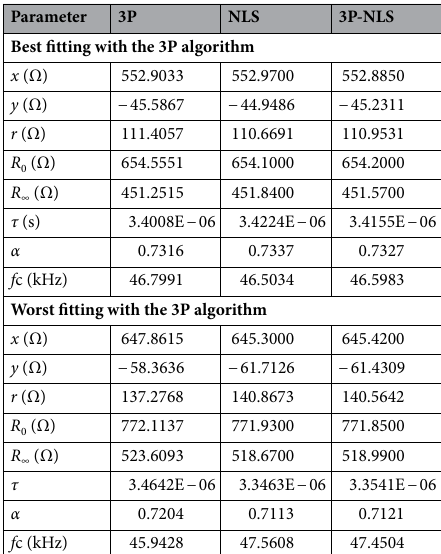
Table 3. Parameter values for the best and the worst fittings obtained from subset 0. Modelled arches of this example are shown in Fig.